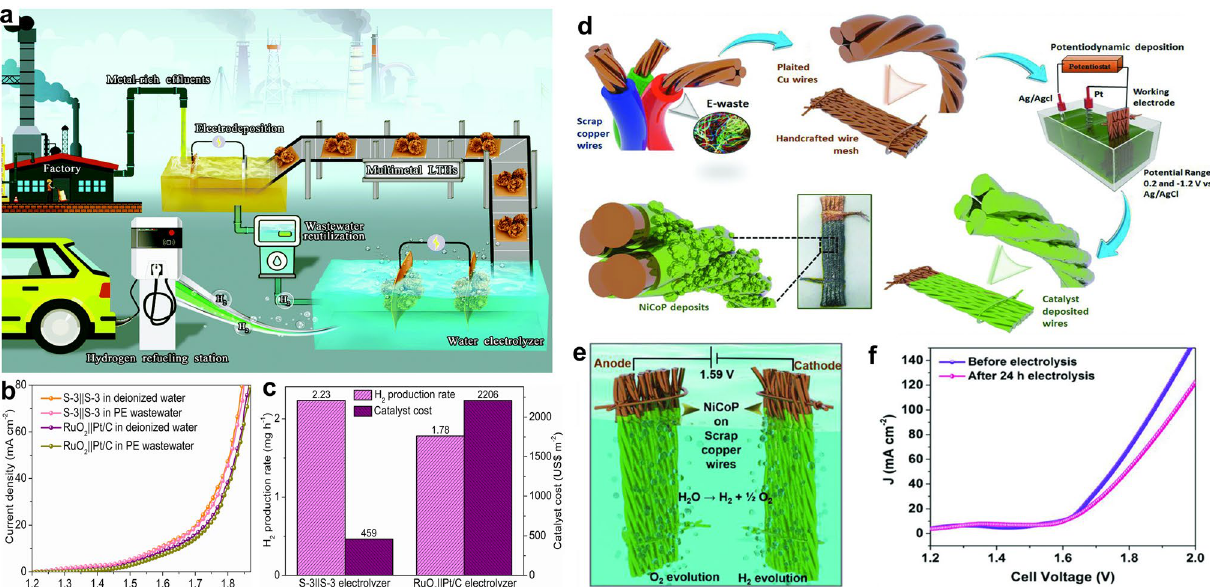
Fig. 13 a Scheme of wastewater electrolyzed by wastewater‑derived NiCoMn LTHs. b LSV curves of OWE of S‑3||S‑3 and RuO 2 ||Pt/C in alka‑ line‑deionized water and post‑electrodeposition (PE) wastewater. c Comparison of hydrogen production rate and catalyst cost for the S‑3||S‑3 and RuO 2 ||Pt/C PE wastewater electrolyzer systems [39]. Copyright 2022, Royal Society of Chemistry. d Schematic of the NiCoP/Cu electrode preparation. e Scheme of the OWE configuration. f LSV curves of NiCoP/Cu electrode before and after 24‑h electrolysis [77]. Copyright